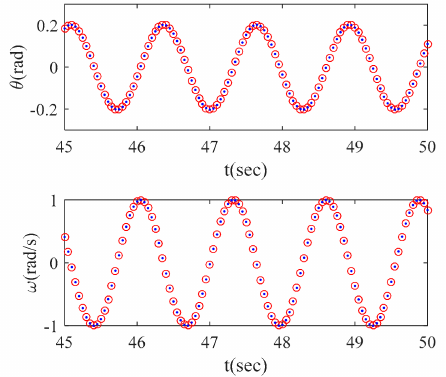
Figure 8. Comparison of two difference